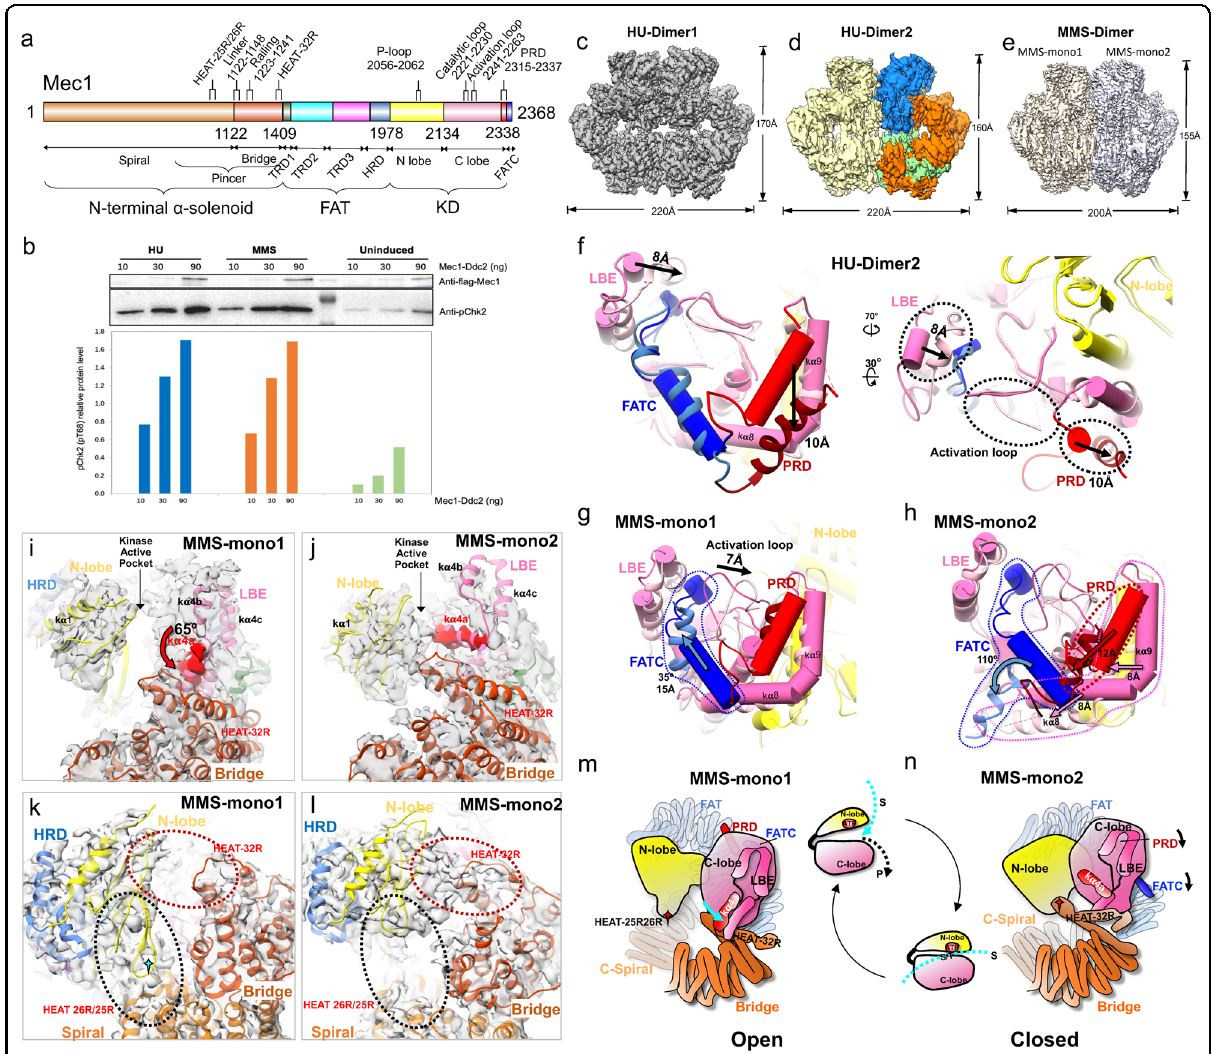
Fig. 1 Structures of the yeast Mec1-Ddc2 complex, a homolog of human ATR-ATRIP, endogenously activated by HU and MMS. a Schematic representation highlighting the functional domains of Mec1/ATR kinase. Three units of Mec1 are labeled: The N-terminal α -solenoid (Spiral and Bridge), the FAT (TRD1, 2, 3 and HRD); and the KD (N-lobe, C-lobe and its PRD and FATC). The same color scheme is used in all structure fi gures. b In vitro kinase assay of the puri fi ed Mec1-Ddc2 complex. Bar representations of the relative kinase activities. c Front view of the density map of the HU-Dimer1. d Front view of the density map of the HU-Dimer2. One monomer is color-coded by domain assignment: FAT-KD-PRD-FATC in blue, N-terminal α -solenoid in orange, and Ddc2 in light green. The other monomer is shown as a solid yellow surface. e Front view of the density map of the MMS-Dimer, with the two asymmetric monomers differently colored. f Comparison of the active site structure of the HU-Dimer2 (shown in ribbons) and that of the Mec1 with basal activity state (shown as transparent pipes). g , h Comparison of the active site structure of the active site of MMS-mono1 and MMS-mono2 (shown in ribbons) with that of the Mec1 harboring basal activity state (shown as transparent pipes). i - l Close-up views of the model-map fi tting of the intramolecular interfaces of the MMS activated Mec1. i, j highlights the conformational variation of the LBE with the motion range labeled. k , l highlights the N-lobe alternatively docks with C-terminal of the Spiral (denoted by a black dashed oval) or with the Bridge domain (denoted by a red dashed oval). m , n A structure-based model illustrating the N-lobe of activated Mec1 kinase alternately packs against the C-terminal of the Spiral or the Bridge, leading to the active site in wide open or tight closed conformations. The LBE K α 4a and Bridge HEAT-32R could function as two gates blocking kinase active